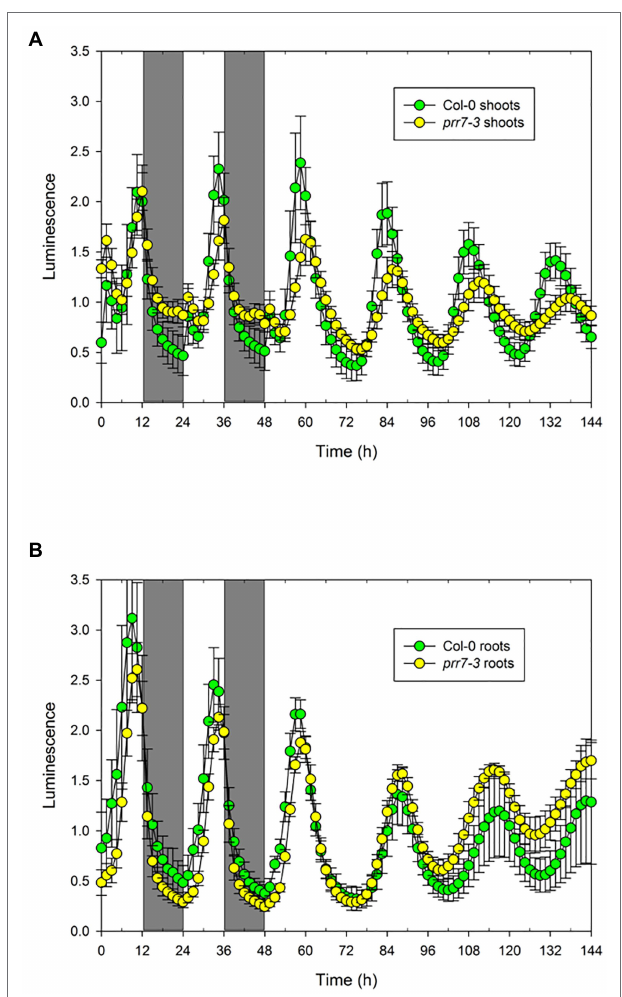
FIGURE 4 | Rhythmicity in prr7-3 shoots and roots. The data show mean ± SD luminescence for Col-0 ( n = 28) and prr7-11 ( n = 20) shoots (A) and roots (B) expressing GI::LUC in two LD cycles followed by 96 h in LL at 25 μ mol/m 2 /s.